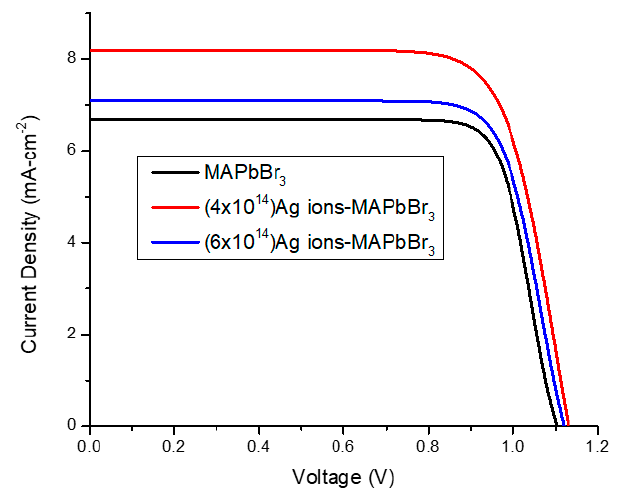
Figure 9. Current density versus voltage curves of MAPbBr 3 and Ag-irradiated MAPbBr 3 . Table 3. Solar cell parameters of MAPbBr 3 and Ag-irradiated MAPbBr 3